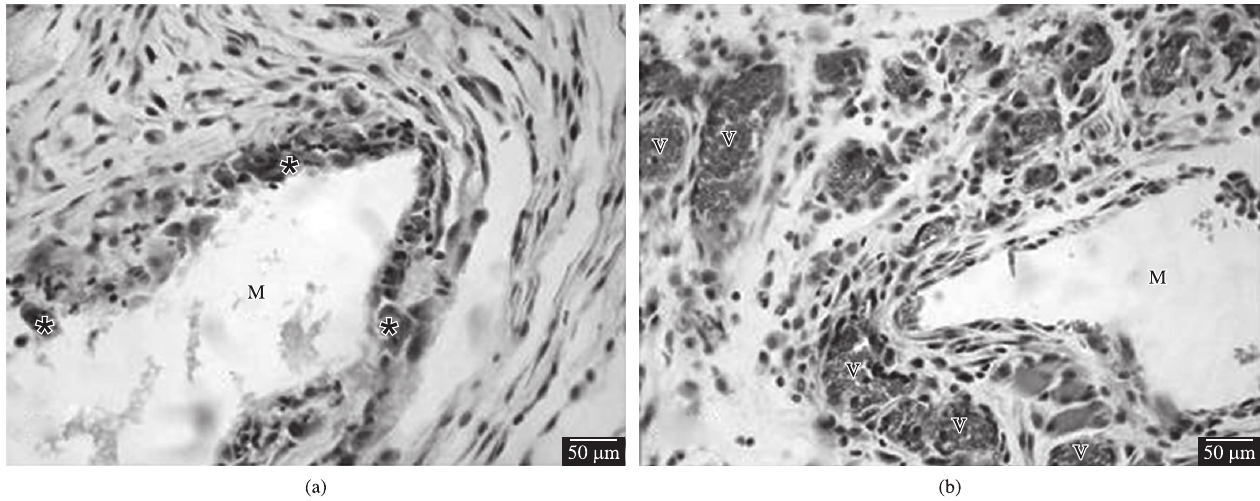
Figure 1. Histological sections, stained with HE, 7 days after grafting with HA (a) or ZnHA (b). Asterisks indicate Multinucleated Giant Cells. (M) indicates the grafted area. (V) indicates blood vessels.